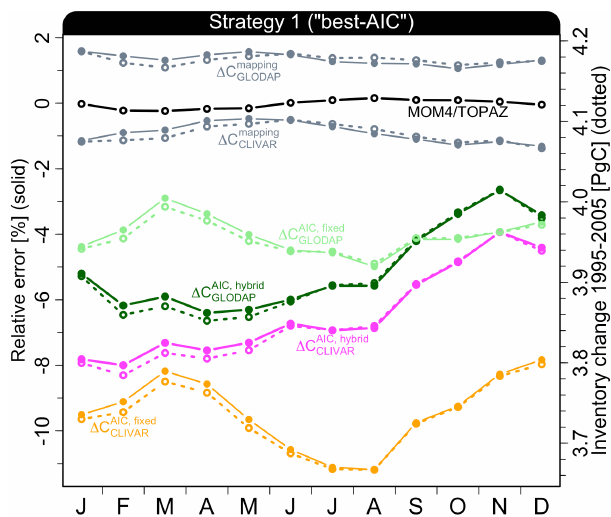
Fig. 6. Relative error (left y-axis) and absolute value (right y-axis) of the anthropogenic carbon inventory change calculated month-by- month between 1995 and 2005. (MOM4/TOPAZ, black) Inventory changes calculated from the “true” values on the original model grid, ( 1C mapping , gray) mapping the “true” values sampled at the X GLODAP or CLIVAR stations, ( 1C hybrid , dark green and magenta) X after mapping the hybrid composite best-AIC solutions obtained from regressions specific for each time and sampling network pro- jected either onto the GLODAP or CLIVAR stations, or ( 1C fixed , X light green and orange) by holding the observational networks fixed in time while allowing for the fixed-network best-AIC models to vary in